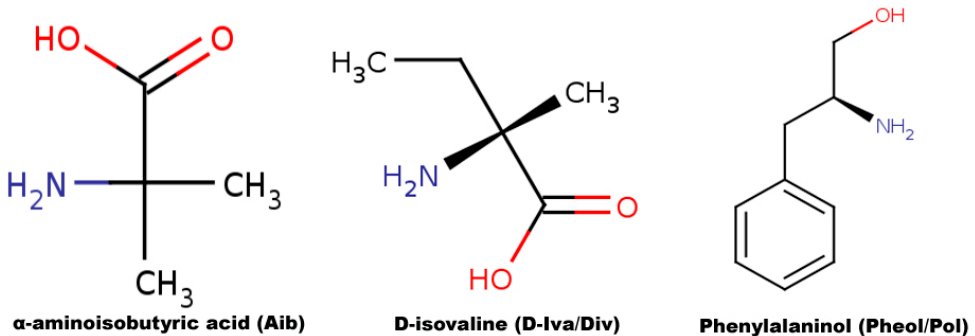
Figure 7. Graphical representation of 2D molecular structures of Aib, Div and Pheol/Pol.